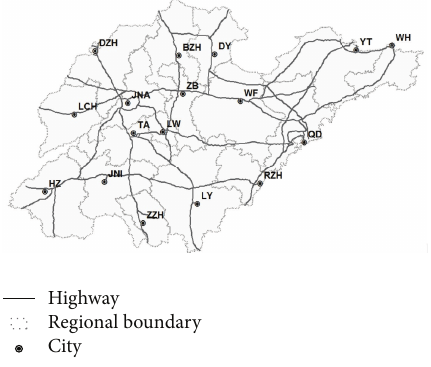
Figure 1: A sketch map of city location and highway infrastructure in Shandong province of